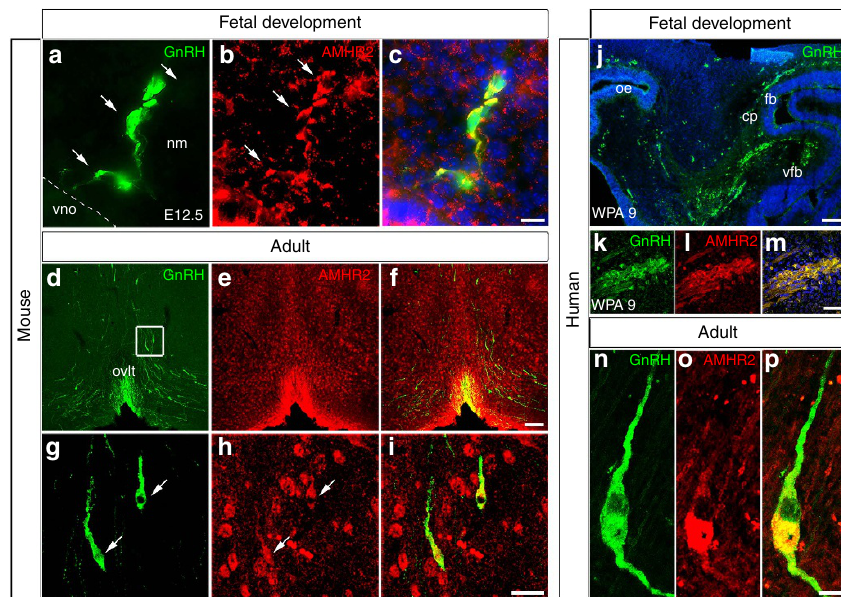
Figure 2 | AMHR2 is expressed in mouse and human GnRH neurons. ( a – c ) Confocal representative photomicrographs showing GnRH and AMHR2 immunoreactivity in sagittal sections of the E12.5 embryonic nasal compartment (number of immunostained E12.5, n ¼ 5). Dashed line indicates the boundary between the vomeronasal organ (vno) and the nasal mesenchyme (nm). GnRH neurons migrating out of the vno express AMHR2. ( d – i ) Confocal photomicrographs showing GnRH ( d , g ) and AMHR2 ( e , h ) immunoreactivity in coronal sections through the hypothalamus of adult female mice (P90–120; number of immunostained brains, n ¼ 5). Images show widespread expression of AMHR2 at the level of the organum vasculosum of the lamina terminalis (OVLT). ( g – i ) High-magnifications images of boxed area in d . Arrows point to GnRH neurons expressing AMHR2. ( j – m ) Representative sagittal section of a human fetus at 9 weeks LMP, immunolabelled for GnRH and AMHR2 (number of immunostained fetuses, n ¼ 3). At this developmental stage, the majority of GnRH neurons are still located in the nasal region, at the beginning of their migratory path. Double immunofluorescence shows co-expression of these antigens in the same migratory neurons. Experiments were replicated at least three times. cp, cribriform plate; fb, forebrain; oe, olfactory epithelium; vfb, ventral forebrain. ( n – p ) Representative coronal section of an adult hypothalamus double labelled for GnRH and AMHR2. Human hypothalami were obtained between 24 and 36h post mortem from two autopsied individuals: a 20-year-old female and a 72-year-old male subject; 17 out of 29 and 20 out of 35 GnRH neurons exhibited AMHR2 immunoreactivity, respectively (analyses have been performed in eight consecutive 16- m m thick coronal sections for